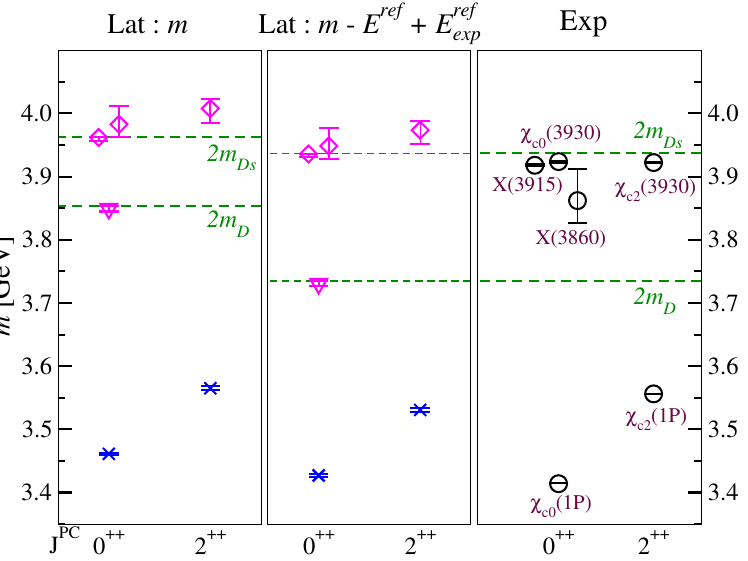
Figure 10 . Energy spectrum of hadrons predicted in this work compared with experiment. The left and middle panes show the lattice results, where m denotes the mass obtained from the lattice study. The magenta symbols correspond to hadrons extracted via the scattering analysis: diamonds represent resonances and triangles represent bound states. The blue crosses are extracted directly from the lattice energies. The reference energy in the middle pane is E ref = 2 m D ( 2 m D the state closest to the D ¯ D ( D s ¯ D s ) threshold, while E ref = M av = 1 remaining four states. The right pane shows the experimental spectrum [2], where χ c 0 (3930) [3] and X (3915) [2] may be the same